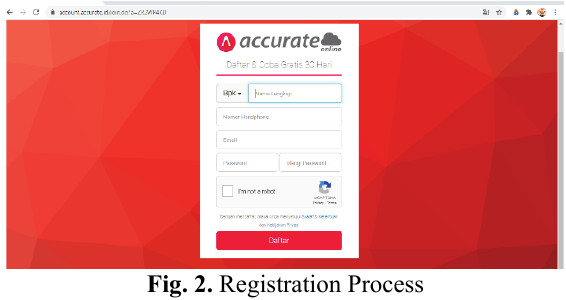
Fig. 2. Registration Process Source: Accurate Online